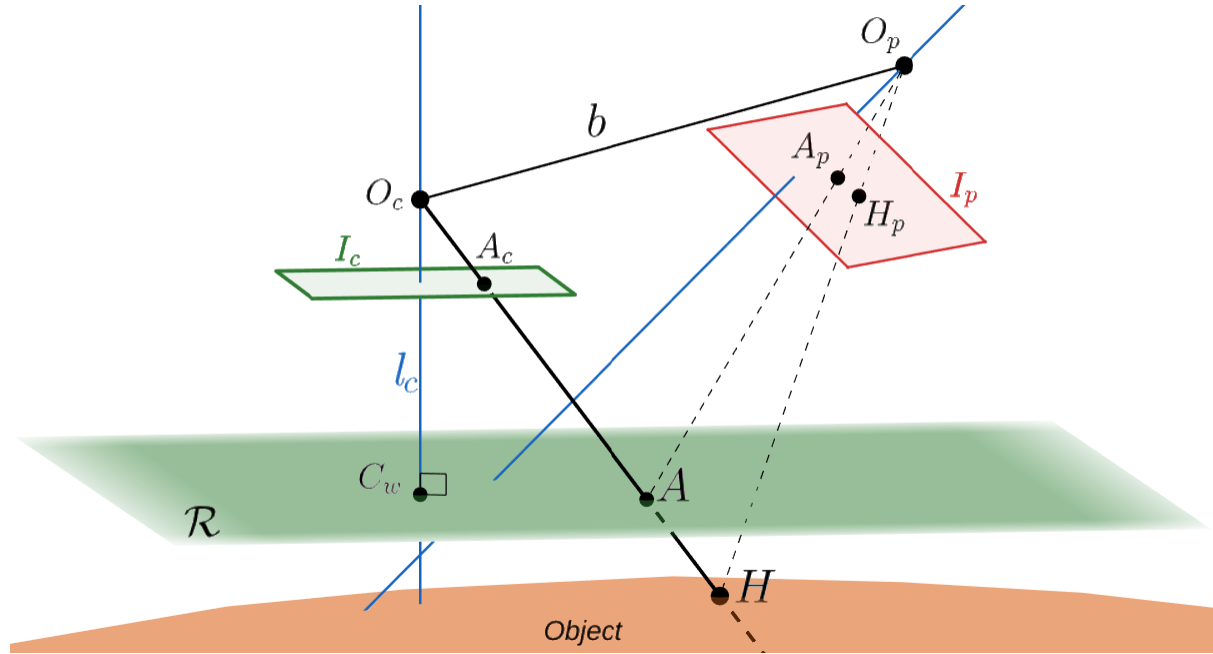
Figure 1. System configuration: camera and projector are freely positioned (optical axes in blue solid). Without loss of generality, camera is placed in the world origin and a virtual reference plane R lays in front of the